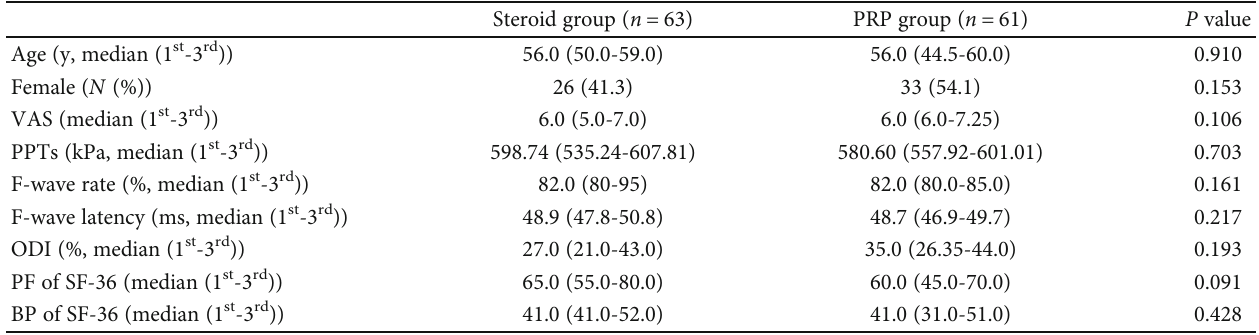
Table 1: Demographic characteristics and baseline information of